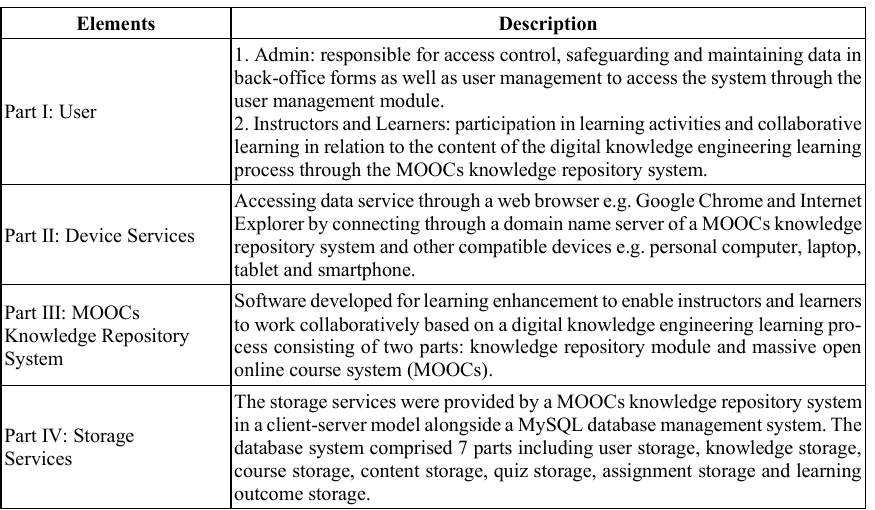
Table 2. Description of the MOOCs knowledge repository system using a digital knowledge engineering process.